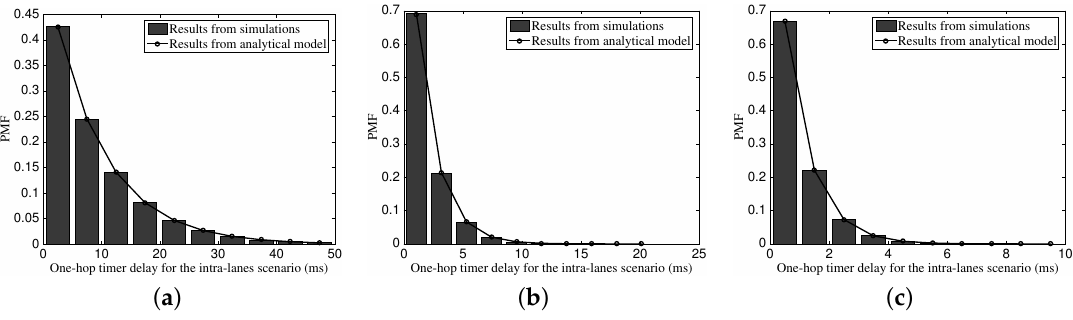
Figure 6. The PMF of one-hop backoff timer delay for the intra-lane scenario with different vehicular traffic density. ( a ) ρ 1 = 10 vehs/km; ( b ) ρ 1 = 50 vehs/km; ( c ) ρ 1 = 100